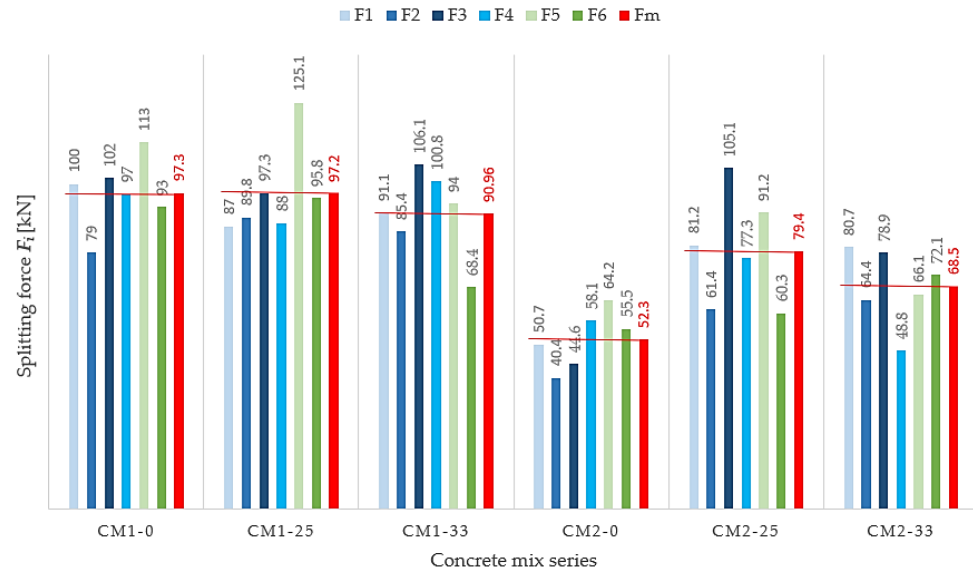
Figure 5. Relative changes in mean values of the compressive strength of concretes in relation to compressive strength in 28 days.